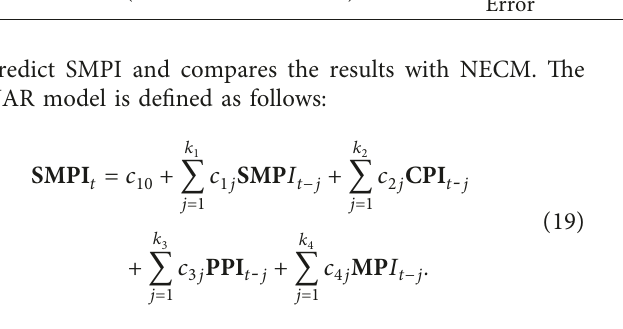
Table 6: Statistical analysis results of Δ SMPI